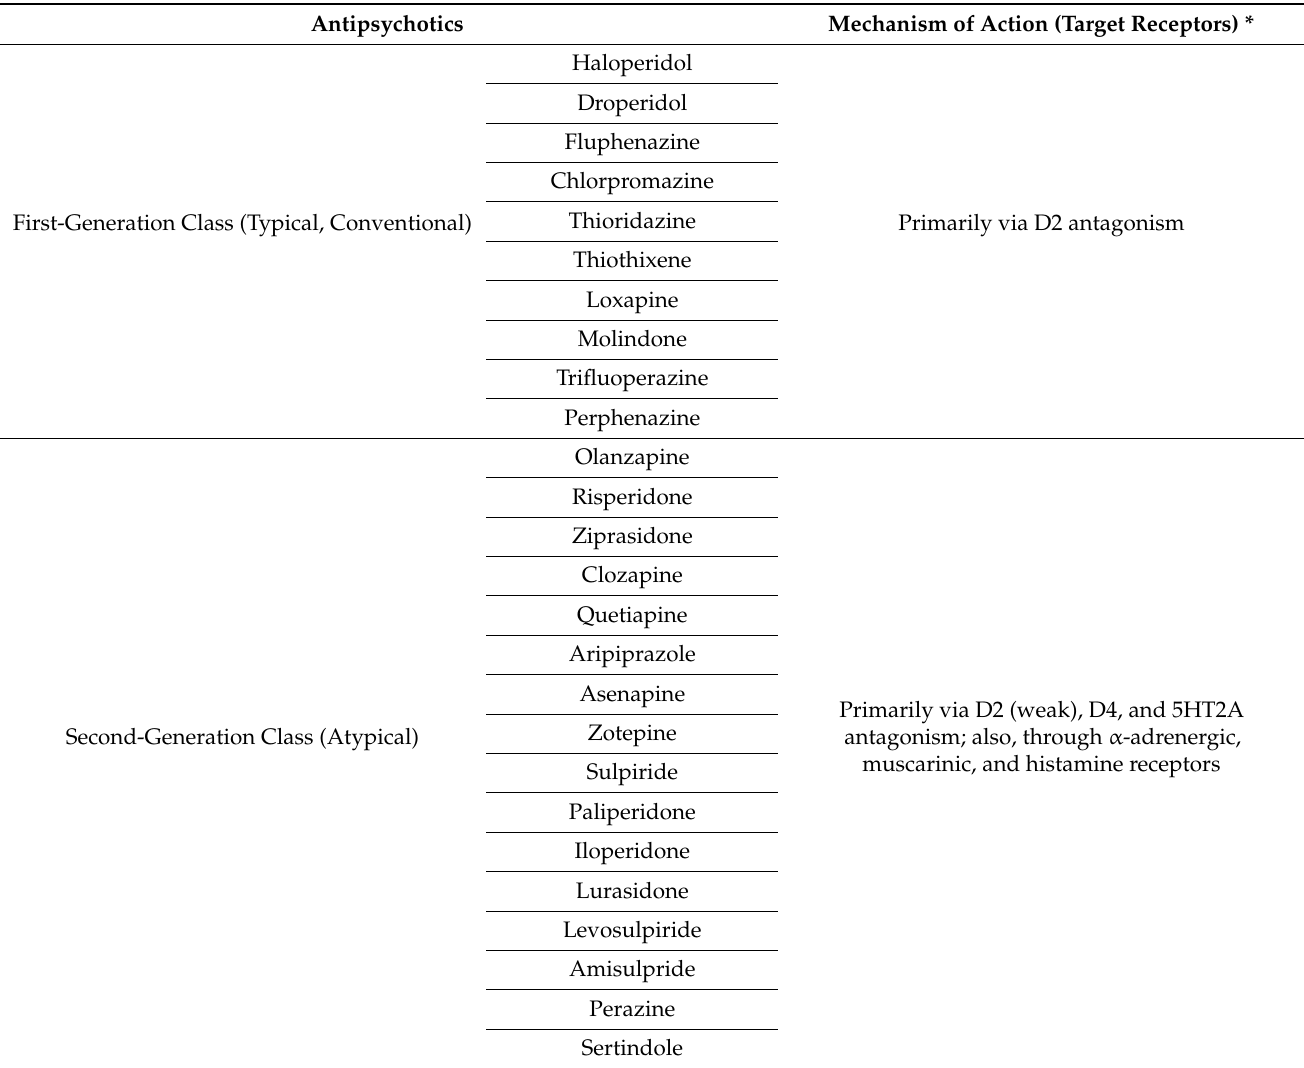
Table 2. Representative typical and atypical antipsychotic drugs with their potential mechanism of